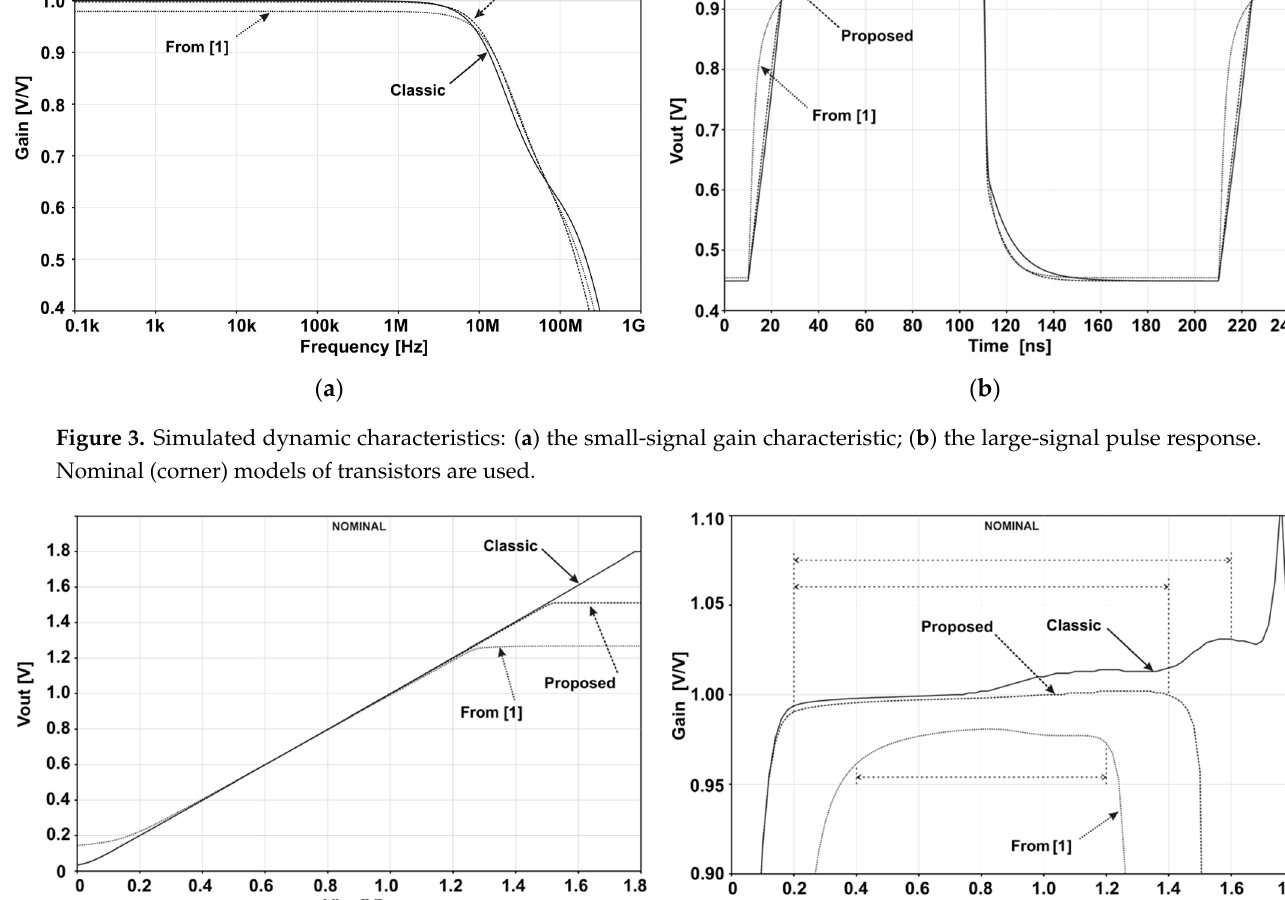
Figure 3. Simulated dynamic characteristics: ( a ) the small-signal gain characteristic; ( b ) the large-signal pulse response. Nominal (corner) models of transistors are used.